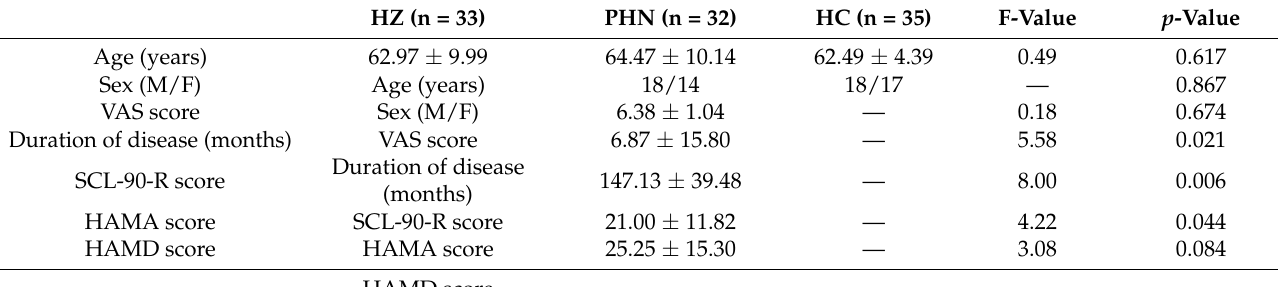
Table 1. Clinical and demographic characteristics of the